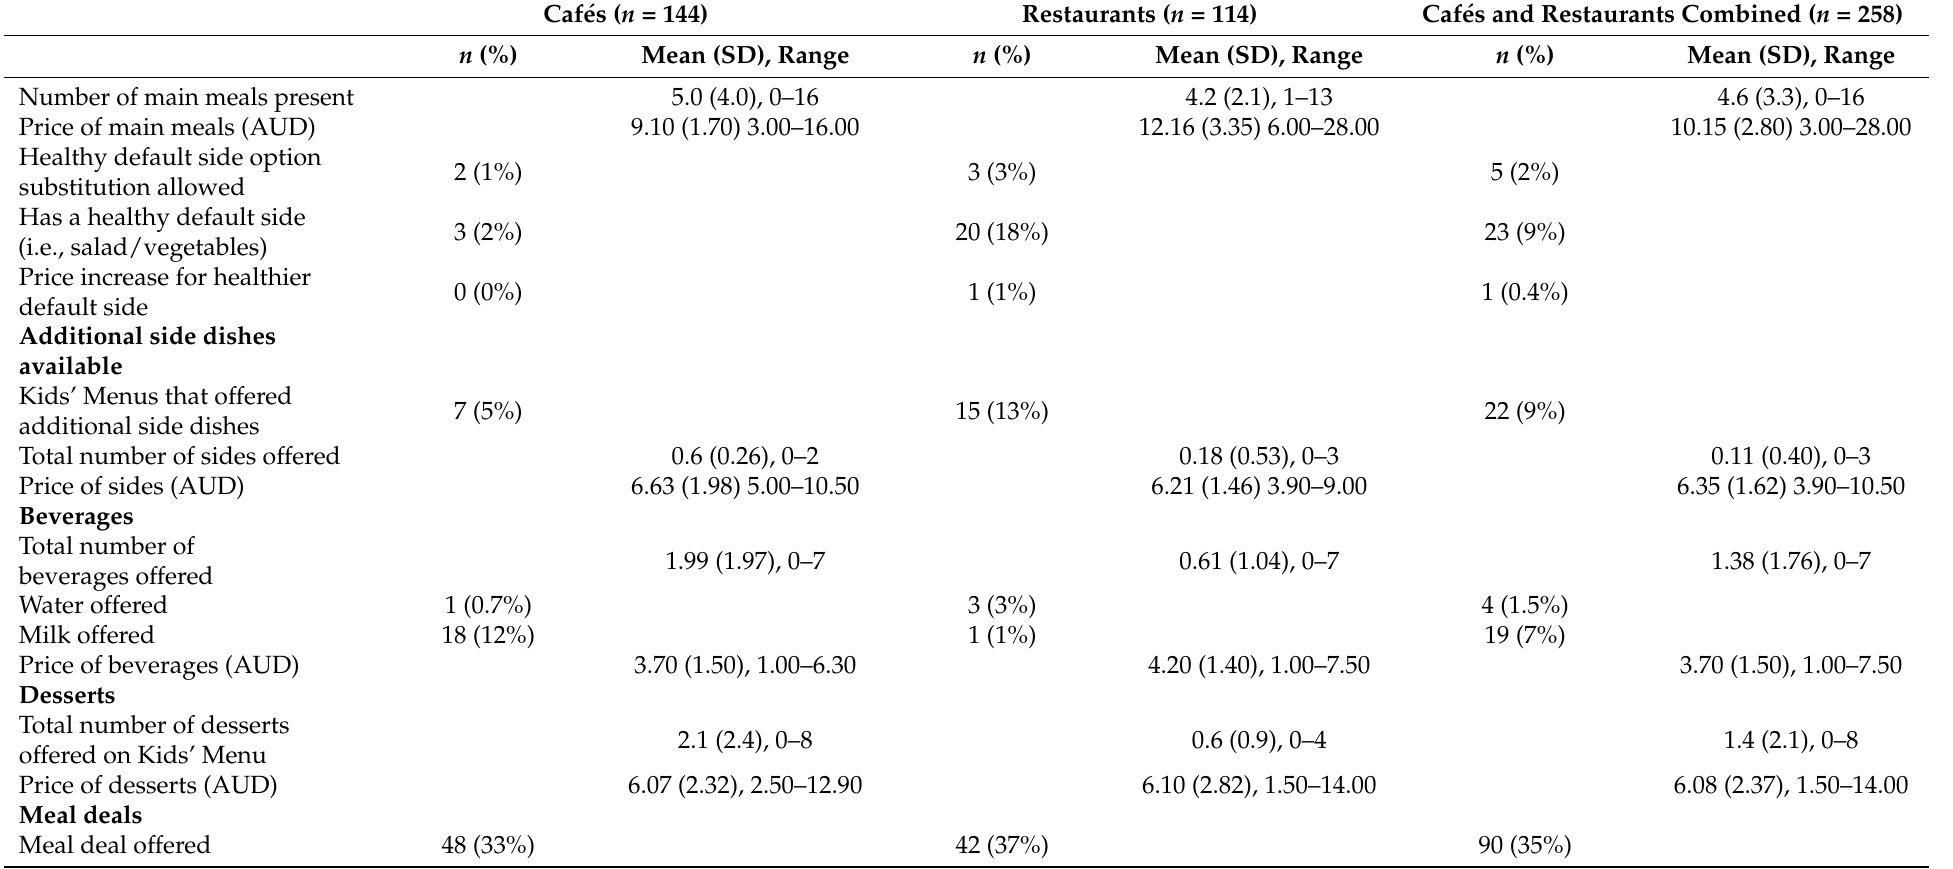
Table 2. Number and price of main meals, side dishes, beverages, and desserts available on Kids’ Menus by food business